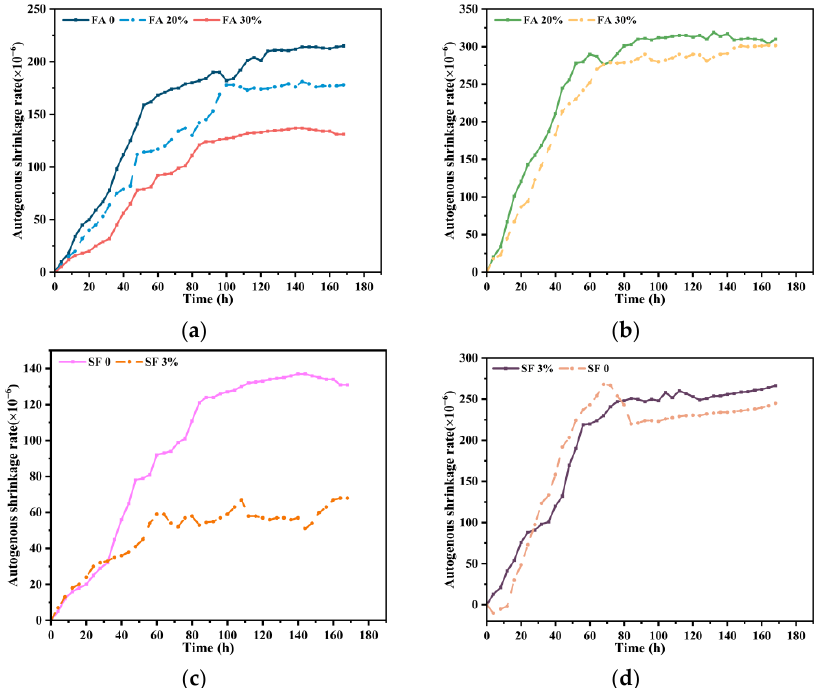
Figure 5. Influence of mineral admixtures on the autogenous shrinkage of PMJC. ( a ) PMJC12, PMJC13, and PMJC14 (W/B: 0.43, SF: 0, EA: 0). ( b ) PMJC16 and PMJC17 (W/B: 0.38, SF: 0, EA: 0). ( c ) PMJC14 and PMJC15 (W/B: 0.43, FA: 30%, EA: 0). ( d ) PMJC18 (EA: 0) and PMJC19(EA: 0.8%) (W/B: 0.38, FA: 30%).